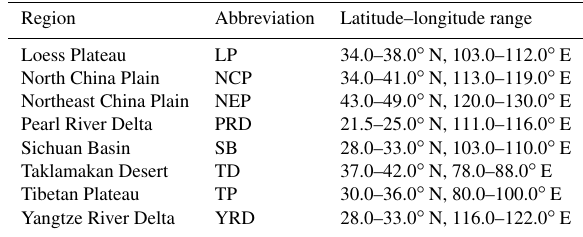
Table 1. Classification of the study